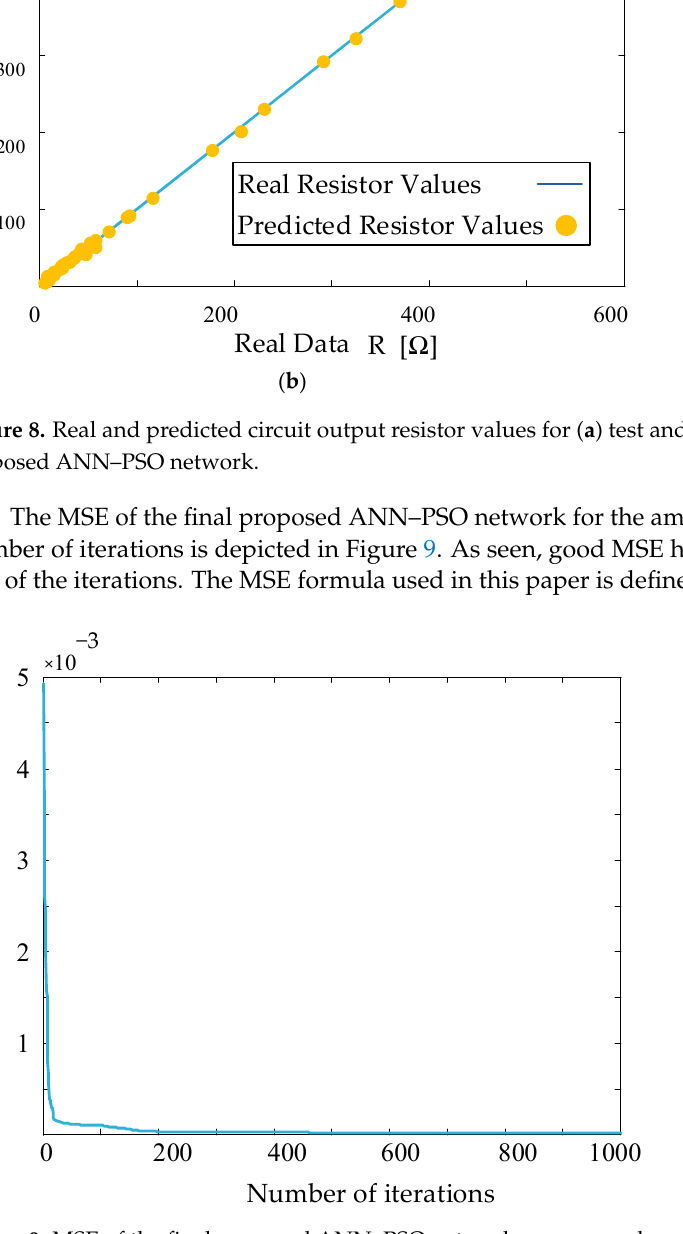
Figure 9. MSE of the final proposed ANN–PSO network versus number of iterations for the output resistor.